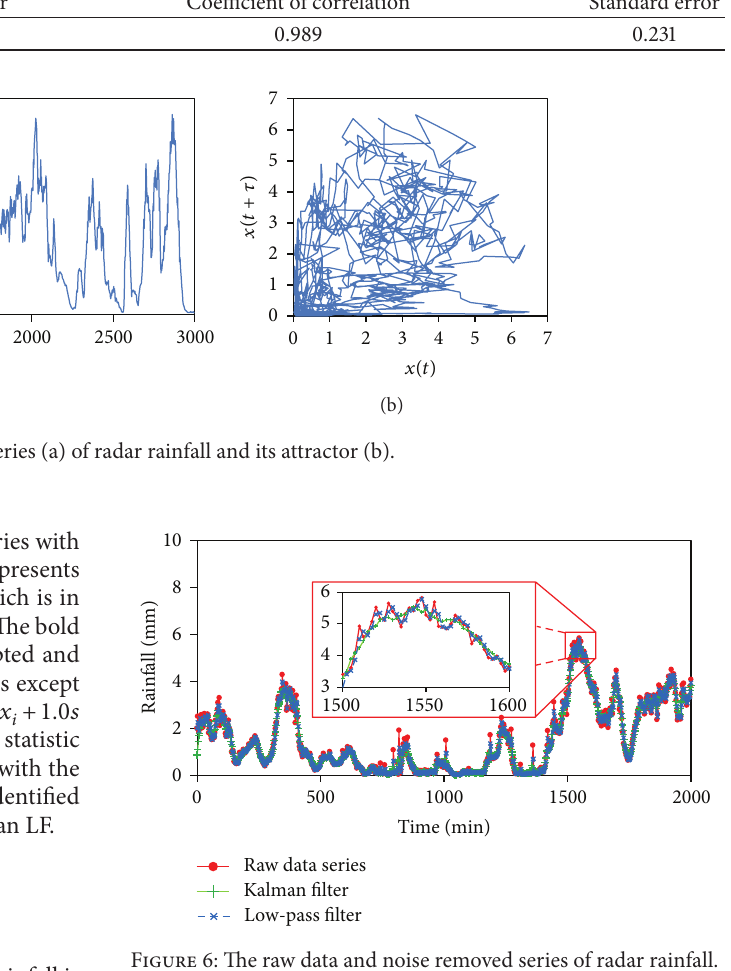
Figure 6: The raw data and noise removed series of radar